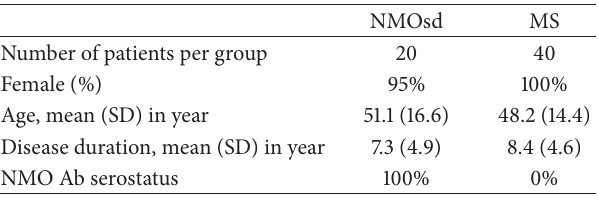
Table 1: Demographic and disease-related characteristics of NMOsd and MS